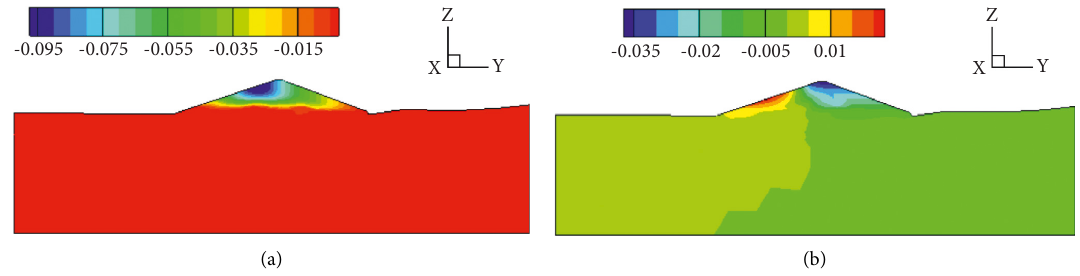
Figure 10: Deformation of dam on the 200th day after the sharp drop in the storage level (m): (a) settlement; (b) lateral